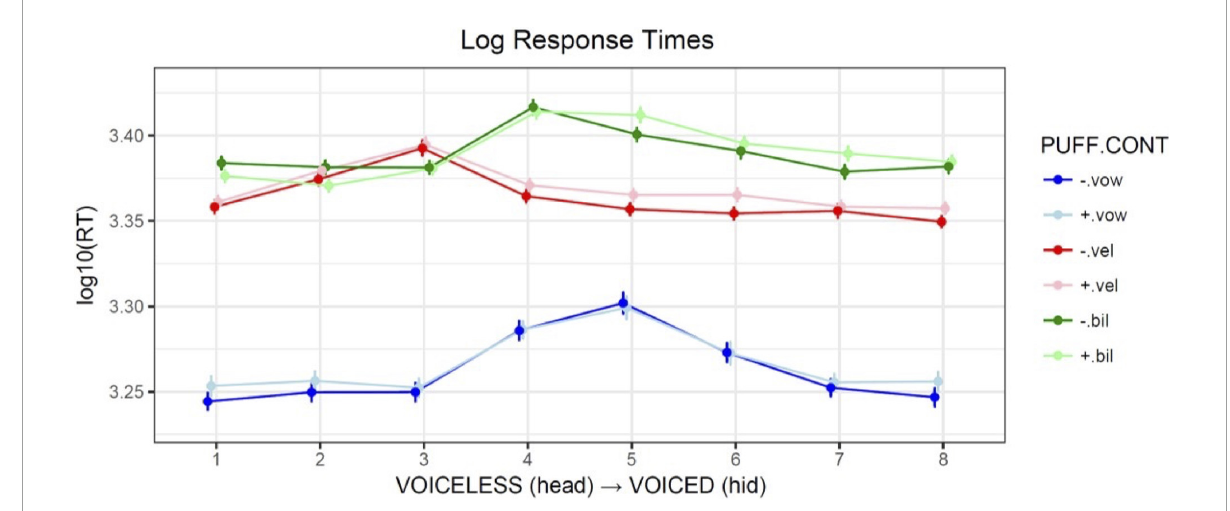
FIGURE5 Comparison of mean log 10 response times averaged across participants, by PUFF (+airflow vs. –airflow), CONTinuum type (VOWel, VELar, BILabial), and continuum STEP. Error bars show the standard error of the mean.